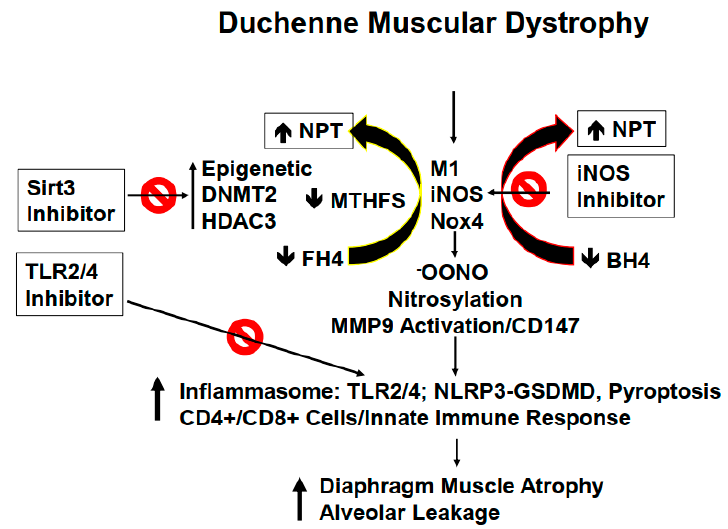
Figure 1. Pulmonary dysfunction caused by the mutated dystrophin protein in DMD patients. The differential interplay of various molecules in DMD patients results in severe lung injury (alveolar leakage) that is further complicated by atrophy of the diaphragm in the affected DMD patients.